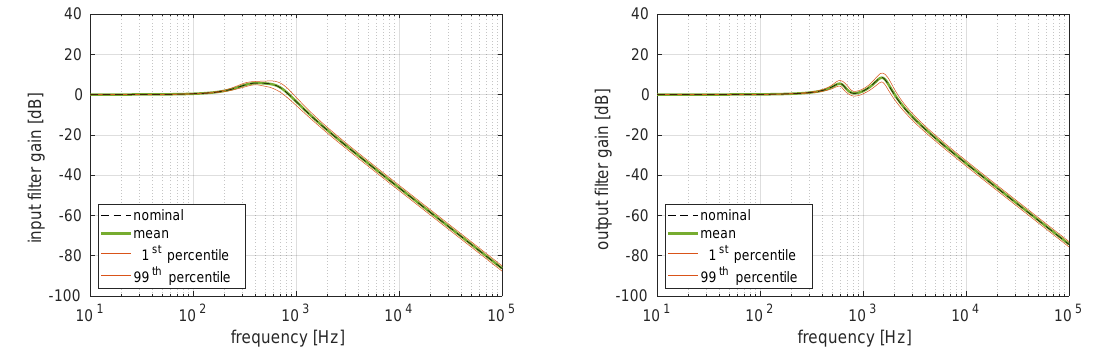
Figure 8. Frequency response of the proposed line/load filter with resonant resistive damper, with variations due to a 10% tolerance in the passive